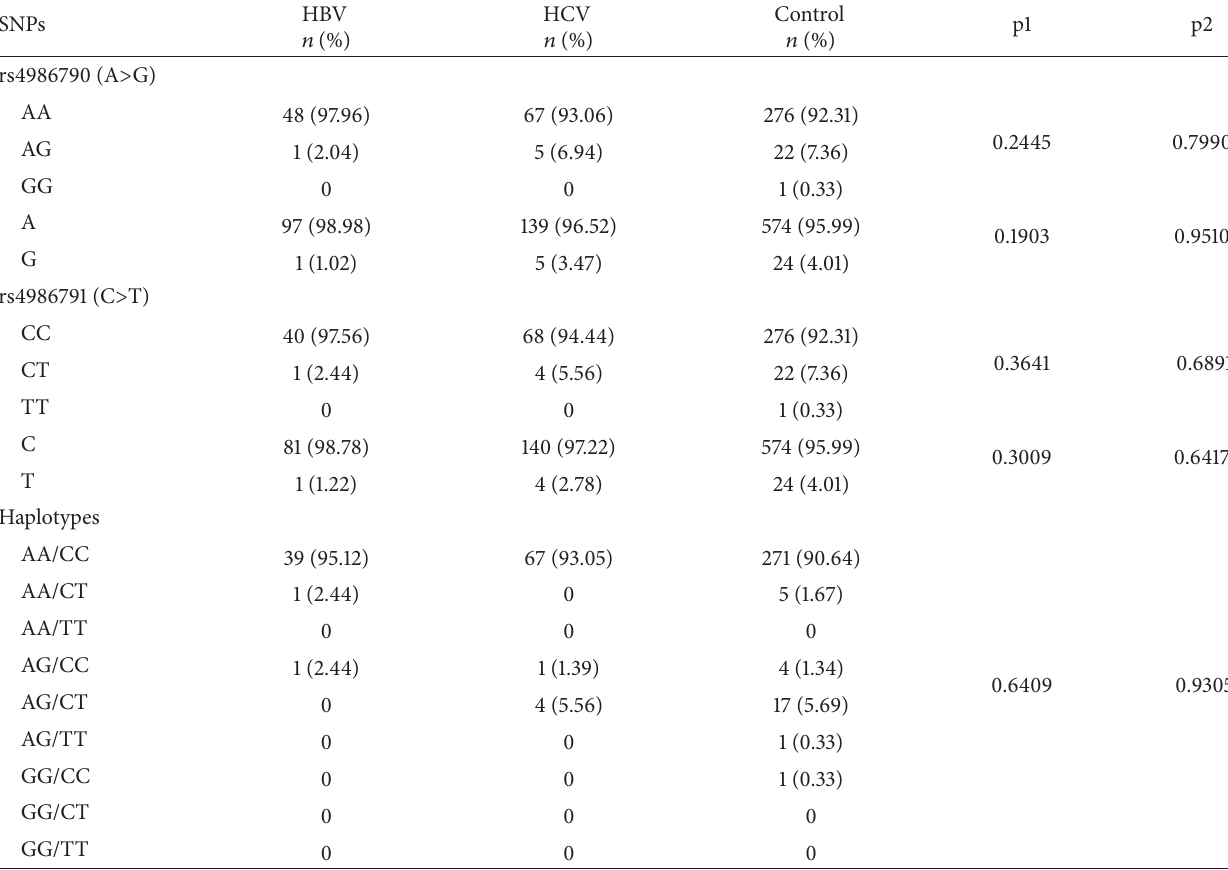
Table 2: Genotype, allele, and haplotype frequencies of SNPs of the TLR4 gene in the investigated groups.